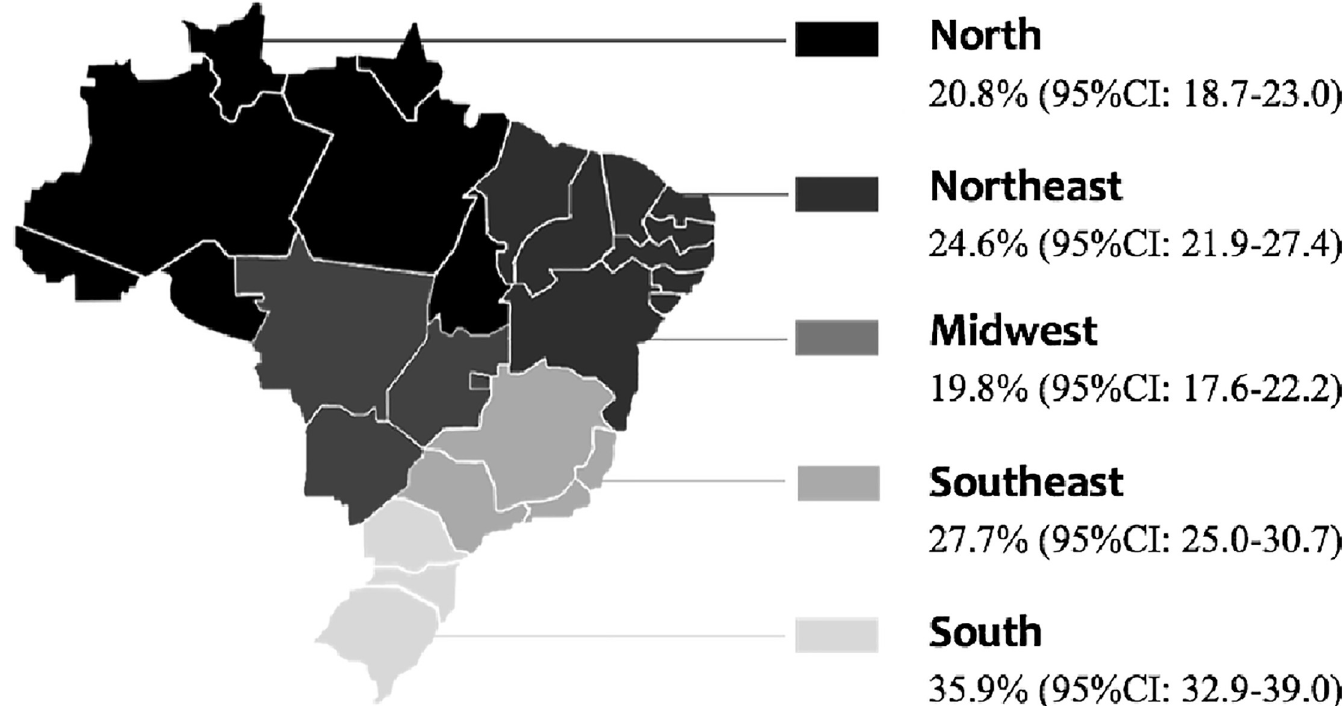
Fig 1. Prevalence of insulin resistance in Brazilian adolescents according to regional distribution. ERICA Study, 2013–2014. 95%CI: 95% Confidence Interval. Source: The authors.